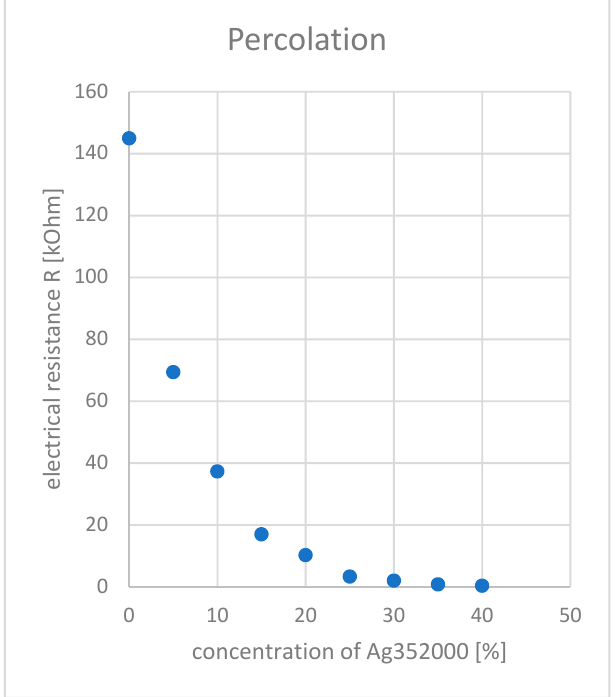
Figure 8. Electrical Resistance R as function of concentration of Ag352000 at 0% elongation.